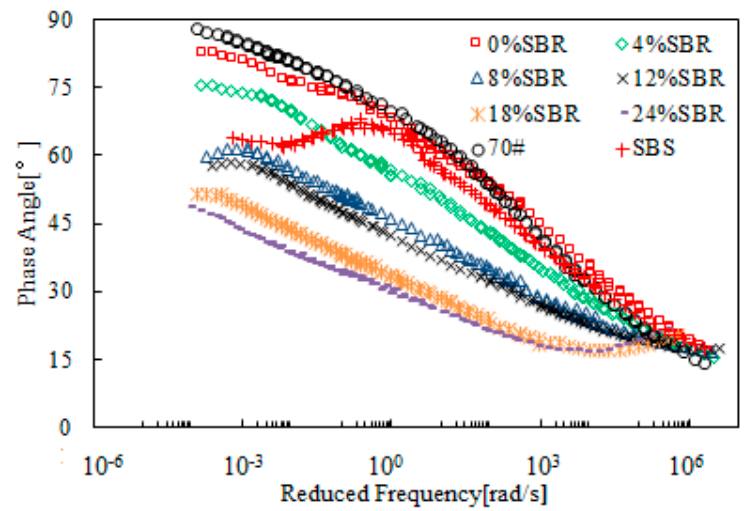
Figure 8. Master curves of phase angle of SBR-modified bitumen emulsion.